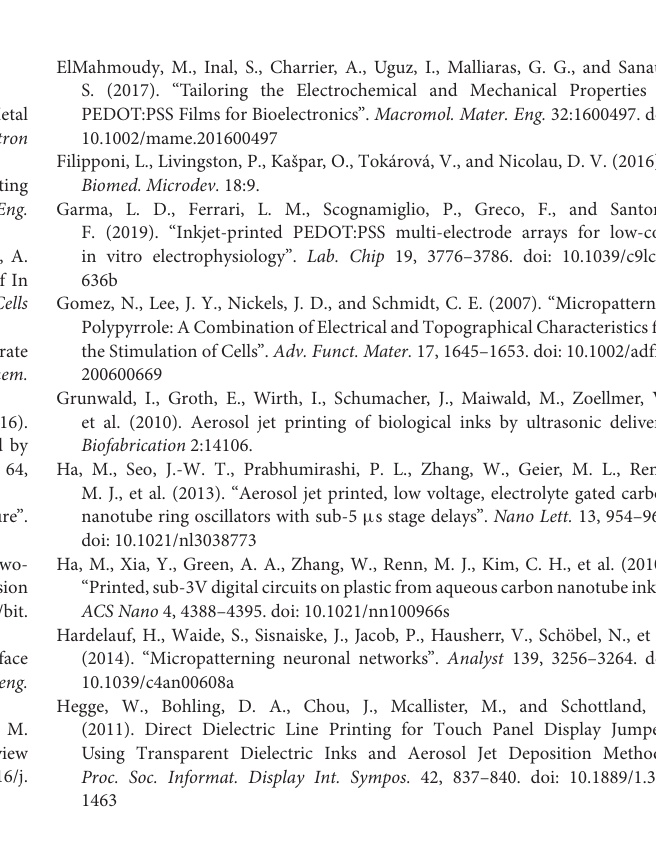
Supplementary Table 4 | Full details of the matrix style DoE carried out to optimize the machine processing conditions for the AJP of PEDOT:PSS. In each trial, each of the three lines were assessed three times for each geometrical feature ( n = 9). Supplementary Table 5 | Analysis of individual variables. Supplementary Table 6 | Analysis of two factor interactions. Supplementary Table 7 | Analysis of three and four factor